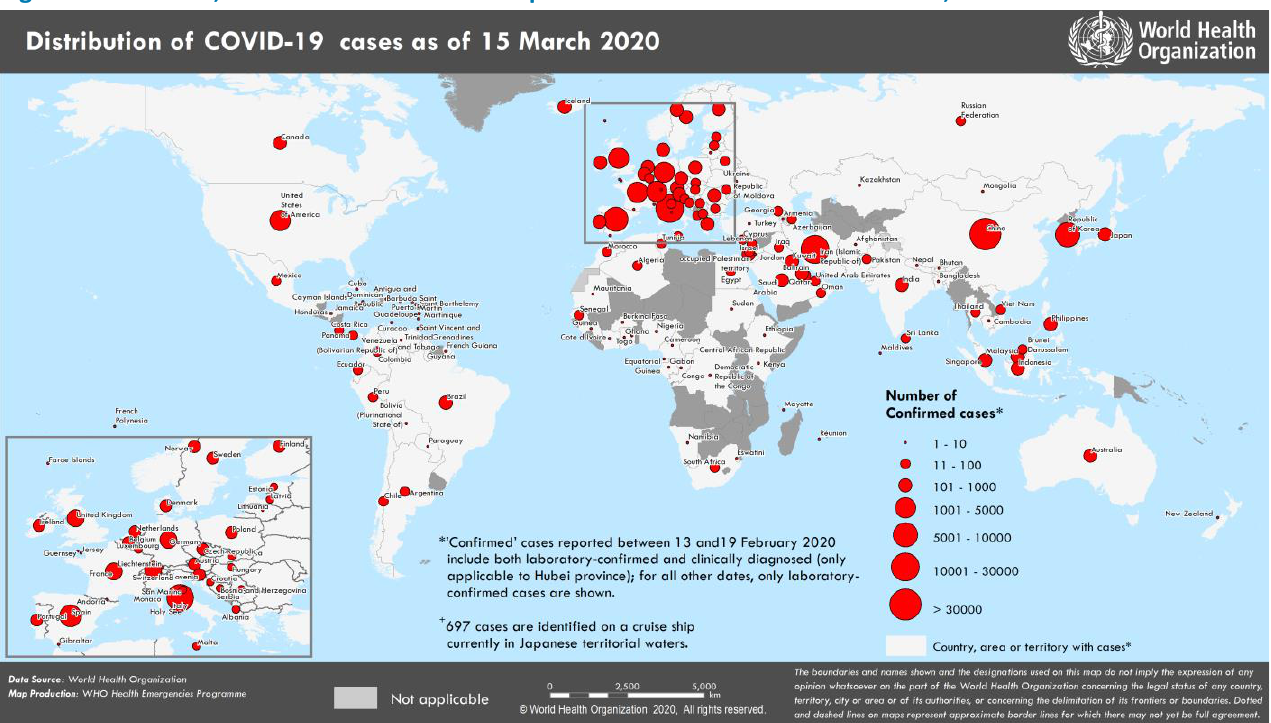
Figure 1. Countries, territories or areas with reported confirmed cases of COVID-19, 15 March